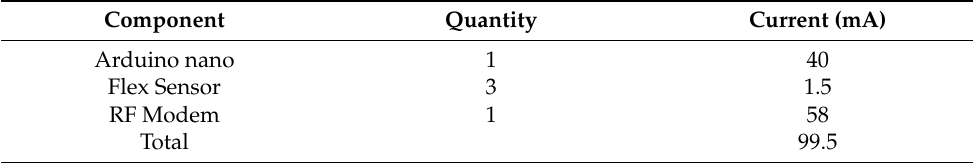
Table 6. Current consumption analysis of the helmet node.